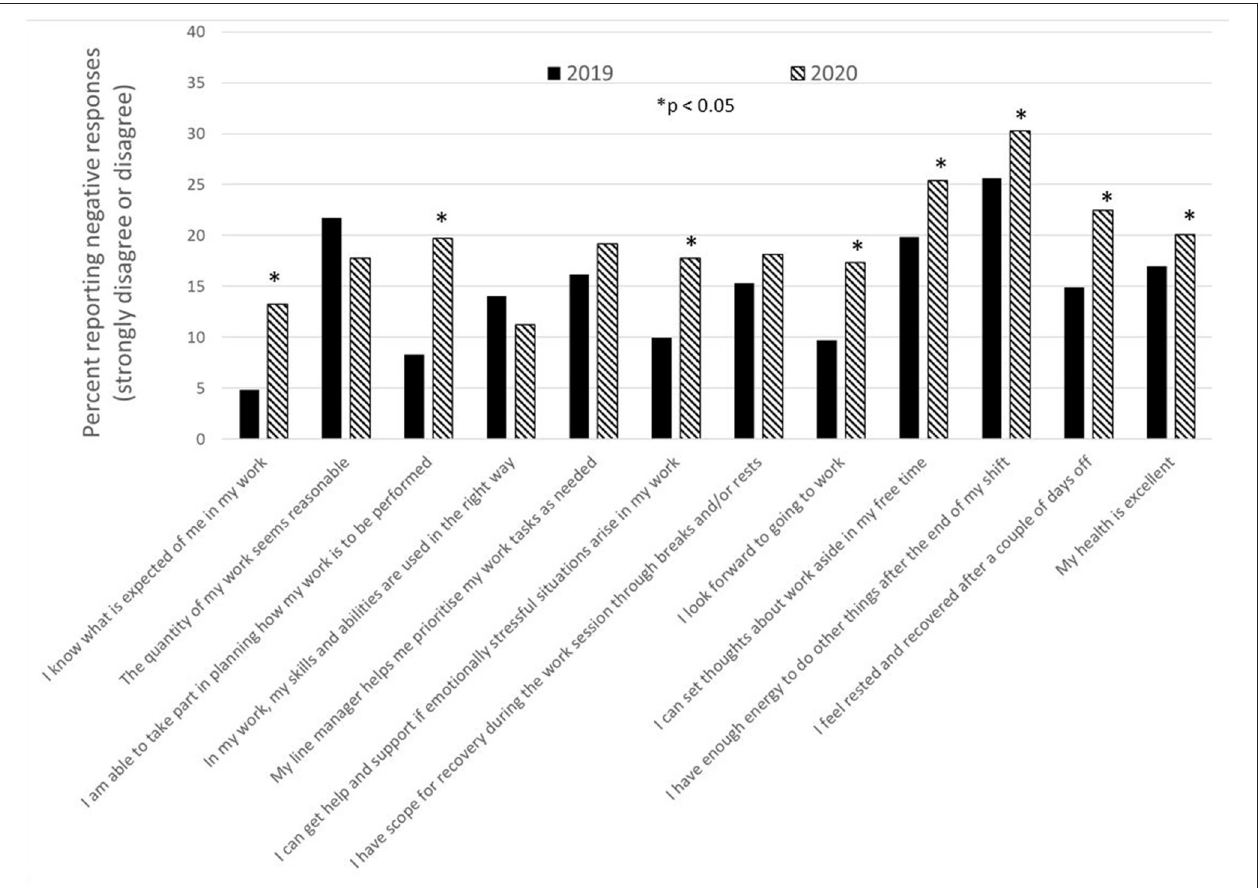
FIGURE 2 | The percentage of negative responses (strongly disagree or disagree) to statements regarding work environment and possibility for recovery before and after the first wave of the COVID-19 pandemic.